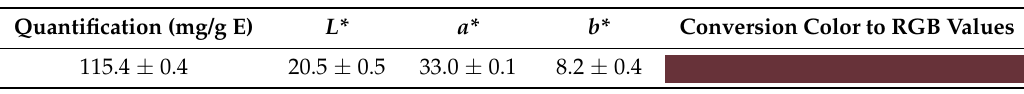
Table 6. Amount of anthocyanins (cyanidin and pelargonidin derivatives) and color parameters under optimal conditions (mean ± SD).